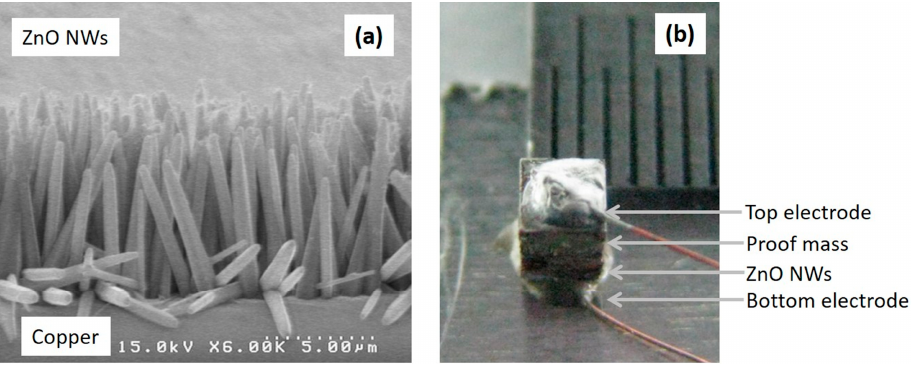
Figure 6. SEM images: ( a ) the grown ZnO NWs; ( b ) the fabricated ZnO NW accelerometer.